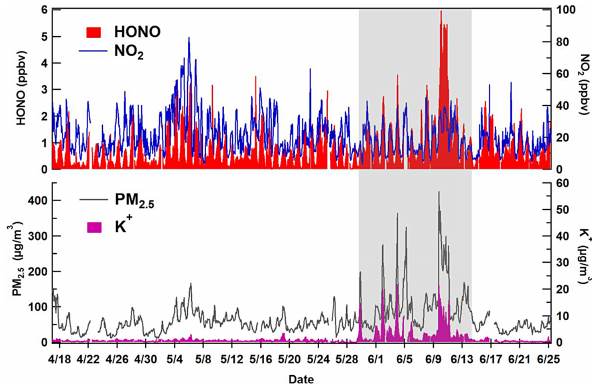
Figure 1. Temporal variation of the concentrations of HONO, NO 2 PM 2 . 5 mass and potassium, at the SORPES station during late April–June 2012. BB episodes mostly occurred during May and early June (shaded in the